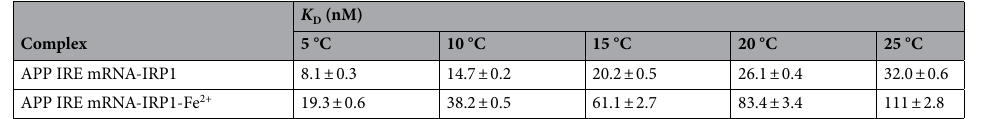
Table 1. Temperature-dependent dissociation constants ( K D ) for the interaction of APP IRE mRNA with IRP1 in the absence and presence of iron (anaerobic).